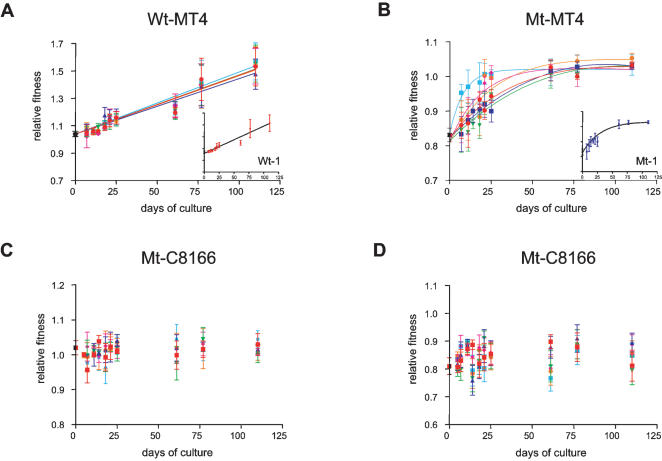
Change in relative fitness of viruses cultured on two distinct T-cell lines.A) The 6 wildtype replicates that are cultured on MT4 T-cells show a linear increase in fitness. The inset shows a single representative example of replicate wt-1. B) The 6 mutant MT4 cultured replicates show an initial fitness increase that seems to reach a maximum at around a relative fitness of 1.04±0.02. All trajectories are best described by an exponential regression model with an upper limit (F-test, p<0.05). The inset shows a single representative example of replicate mt-1 (see Table 2 for relative fitness values at day 110). C and D) relative fitness of 6 wt and 6 mt C8166 cultured viruses, respectively. Relative fitness did not significantly deviate from the starting virus over the course of the experiment (ANOVA, p>>0.05; see Table 3 for relative fitness values at day 110). Fitness is relative to reference strain v13 (also see materials and methods section.